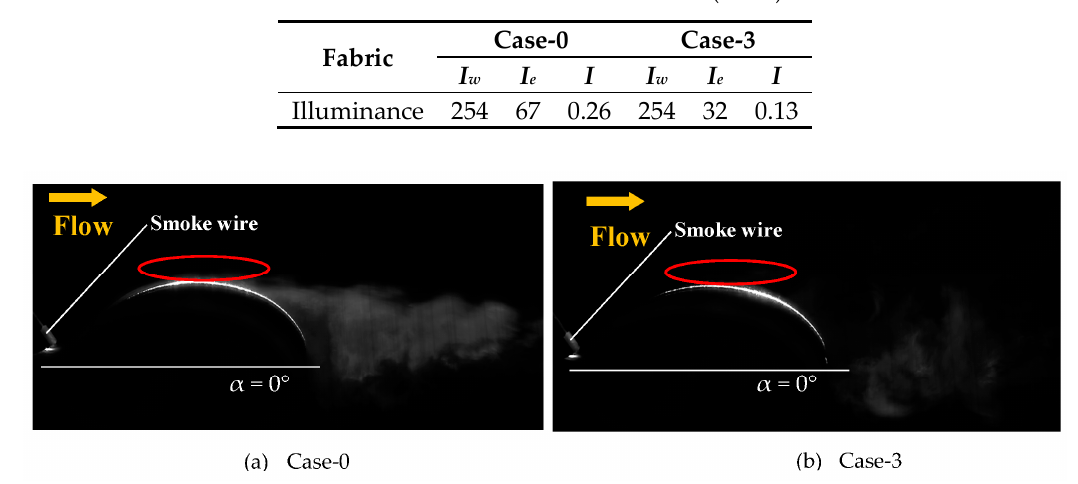
Table 2. Illuminance ratio of smoke flow ( α = 0°).